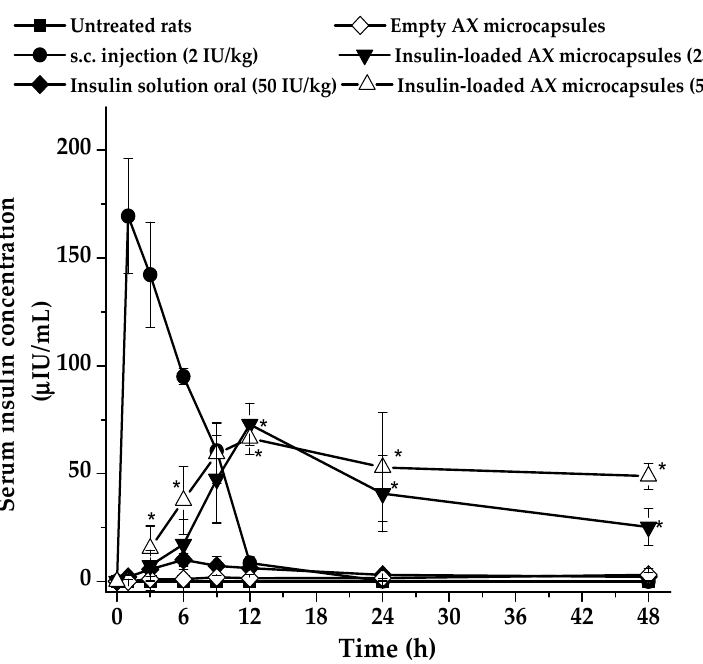
Figure 7. Serum human insulin levels of diabetic rats after oral or subcutaneous administration of formulations. Data represent the mean ± SD, n ≥ 5 per group. * p < 0.05 compared to s.c. Table 3. Pharmacokinetics parameters for serum insulin levels in the diabetic rat model. Insulin